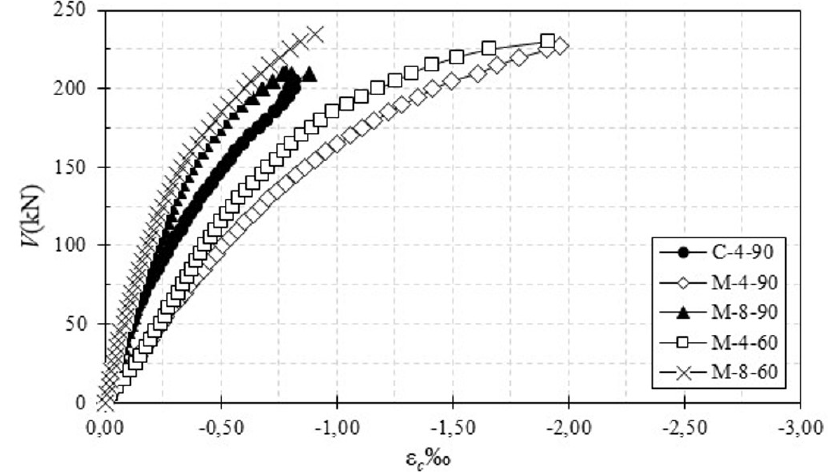
Figure 10 – Shear force versus Concrete